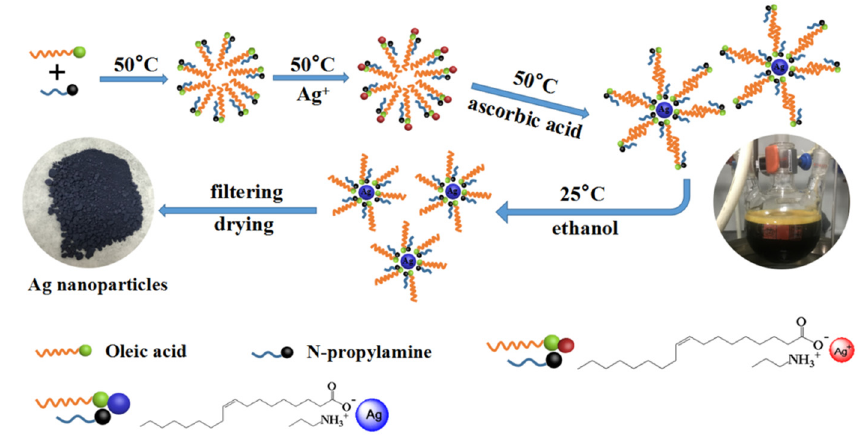
Figure 1. Synthesis procedure of Ag nanoparticles.